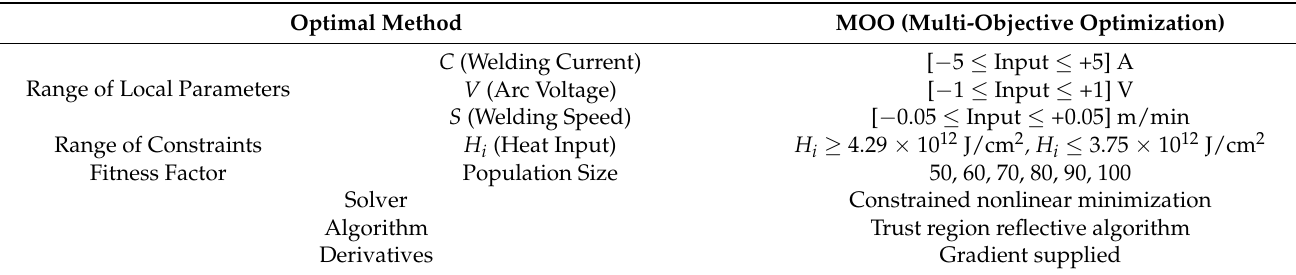
Table 13. Multi-objective optimization algorithm parameters and their values.